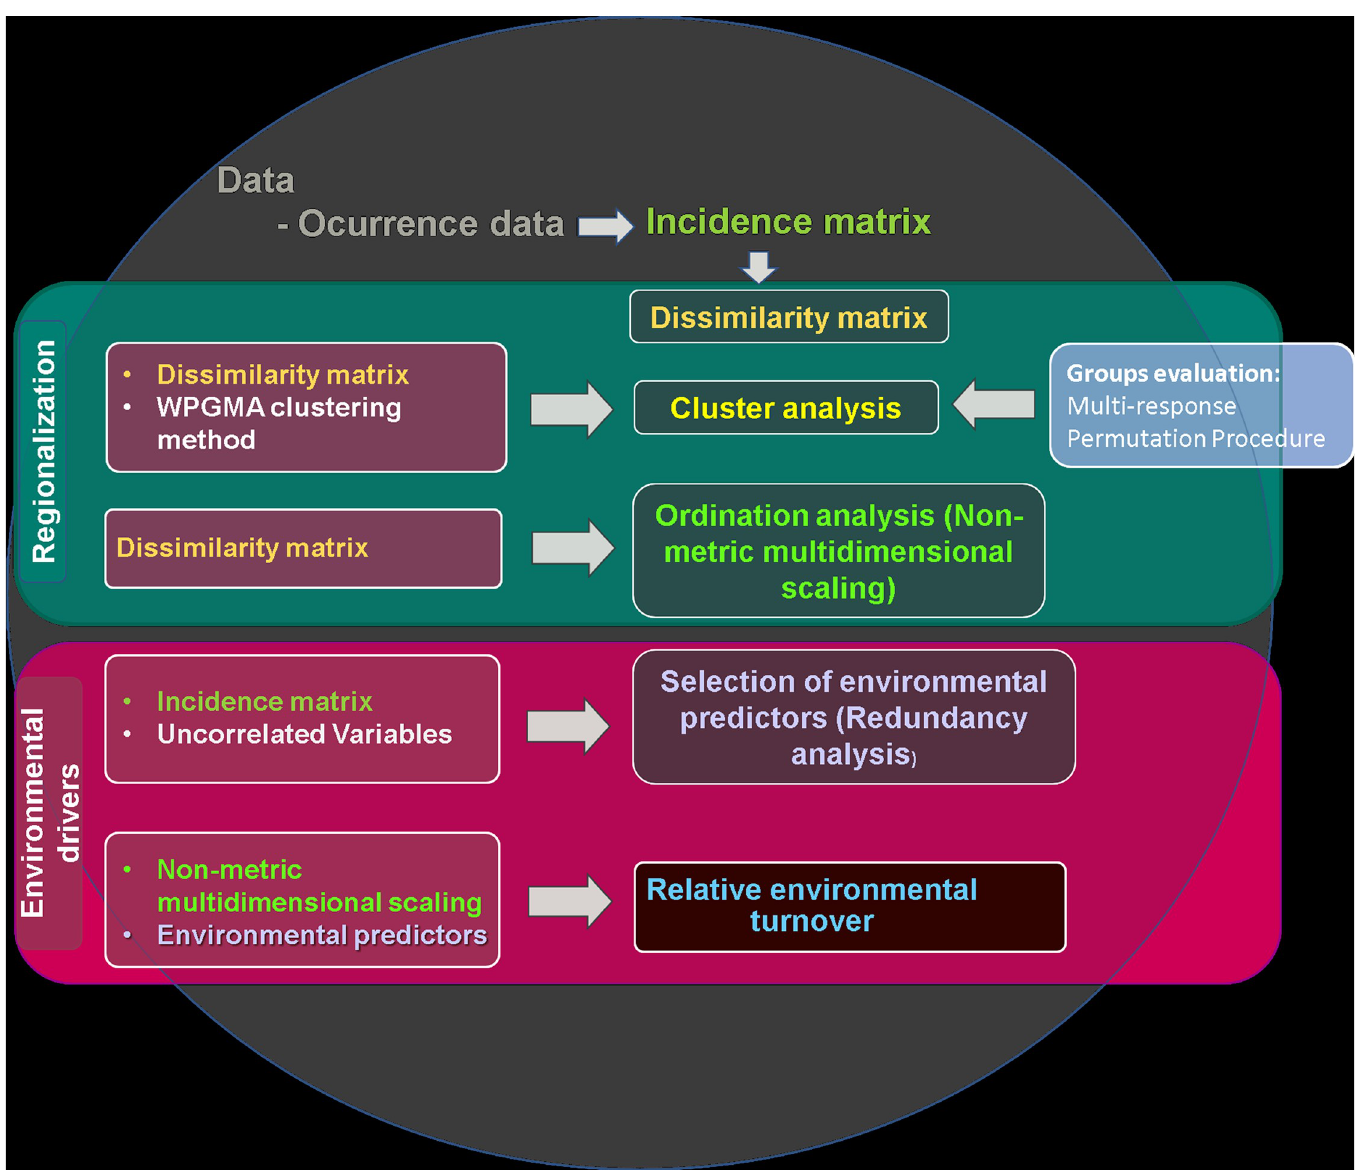
Fig 1. Schematic workflow of the proposed framework for biogeographic regionalization and spatial analysis at the regional level. Each panel shows the analysis carried out and the inputs used.